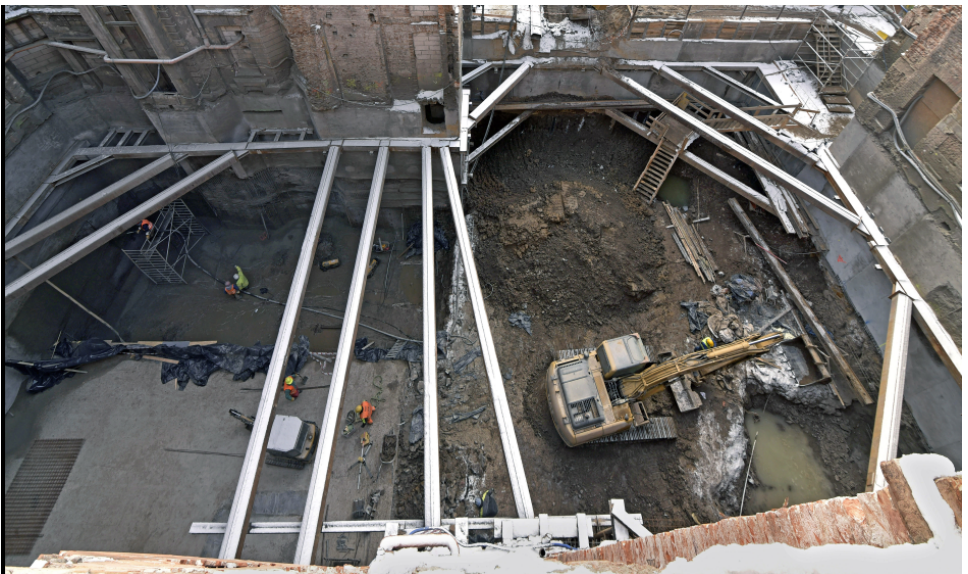
Figure 2. Construction pit – blinding concrete in process.